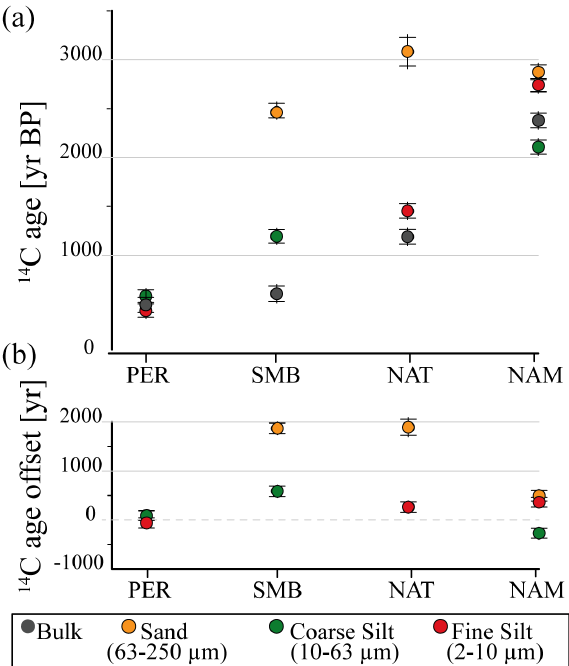
Figure 4. Radiocarbon ages of alkenones contained in bulk and grain-size fractions at each study site (a) and age discrepancies be- tween 14 C ages of alkenones in size fractions and corresponding bulk sediment (b)